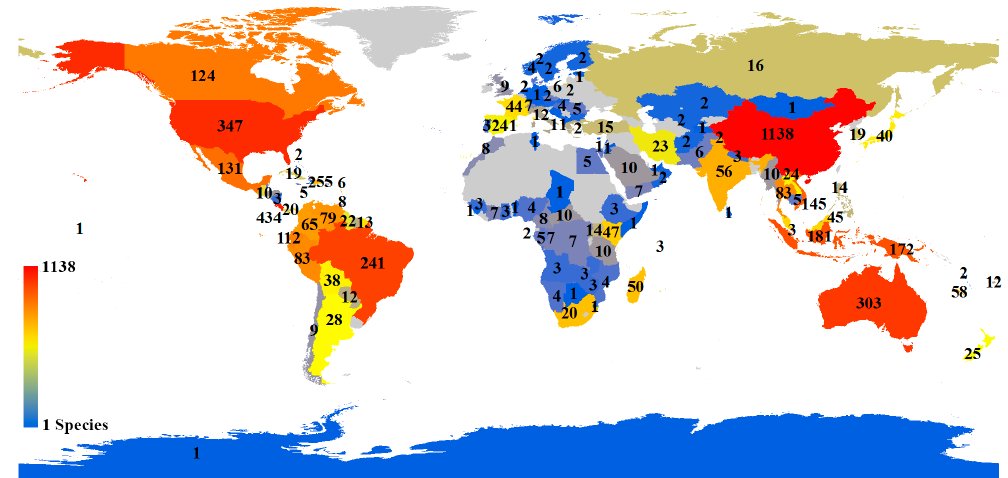
Figure 6. The distribution map of 4811 insect new species from 2009 to 2017 based on collection localities of the holotypes. Different colors represent total number of species described from different countries in this period.